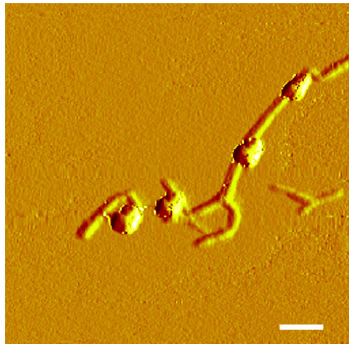
Figure 5. AFM image for the AuPdNPs @ TOCN composite (Au:Pd = 3:1). Scale bar corresponds to 100 nm. Notice: horizontal resolution is limited in analytical principle